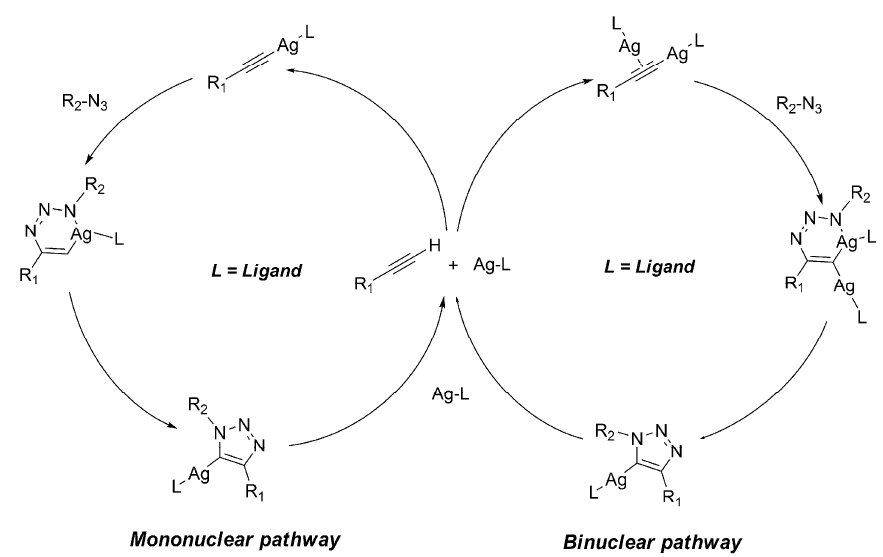
Figure 1. Proposed catalytic cycles for the AgAAC reaction.